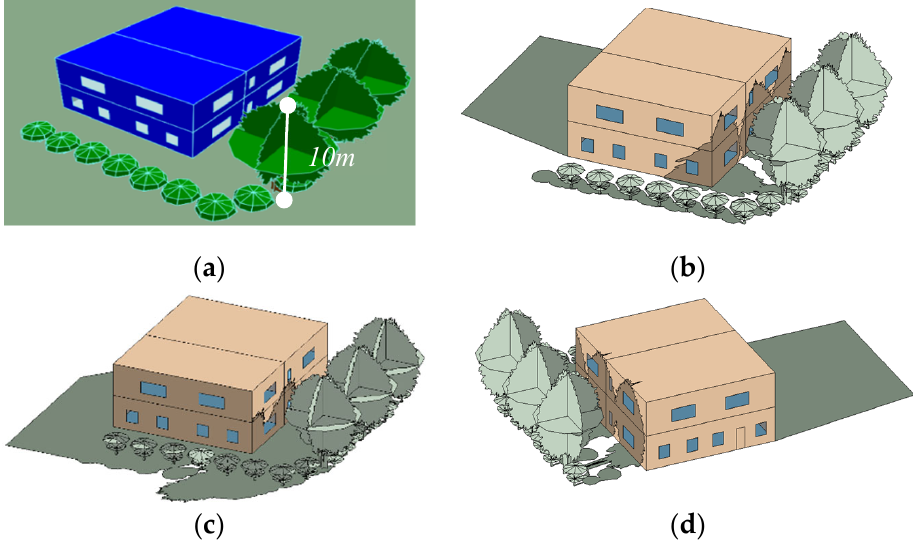
Figure 15. The selected landscaping design ( a ) and its shading impact at ( b ) Summer Solstice (at 17:00), ( c ) Winter Solstice (at 15:00), ( d ) Equinox (at 17:00).